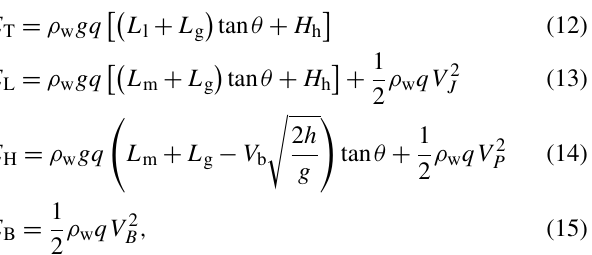
imum rate of energy dissipation expressed by Yang (1971a,